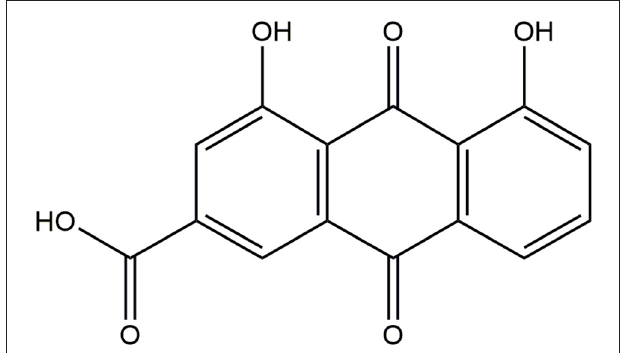
FIGURE 1 | Chemical structure of